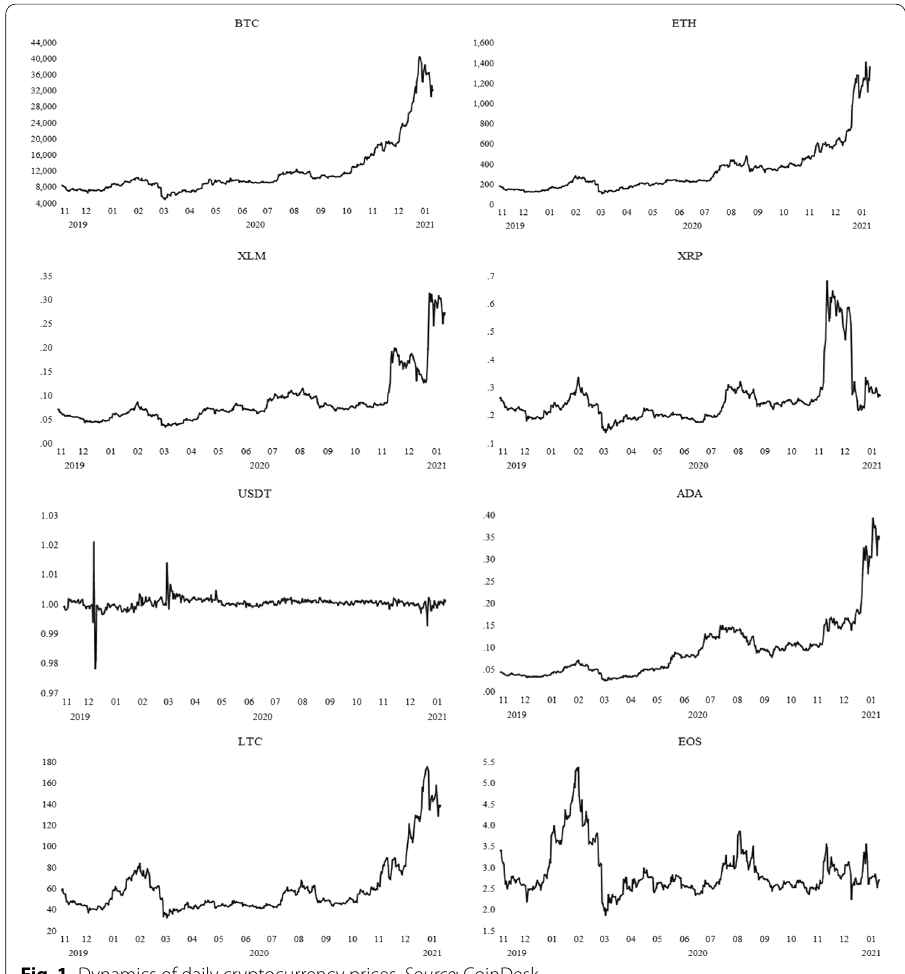
Fig. 1 Dynamics of daily cryptocurrency prices. Source :